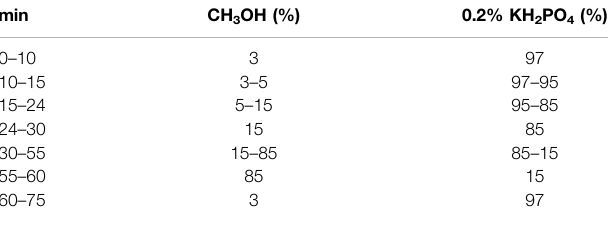
TABLE 1 | Mobile phase condition of chromatographic